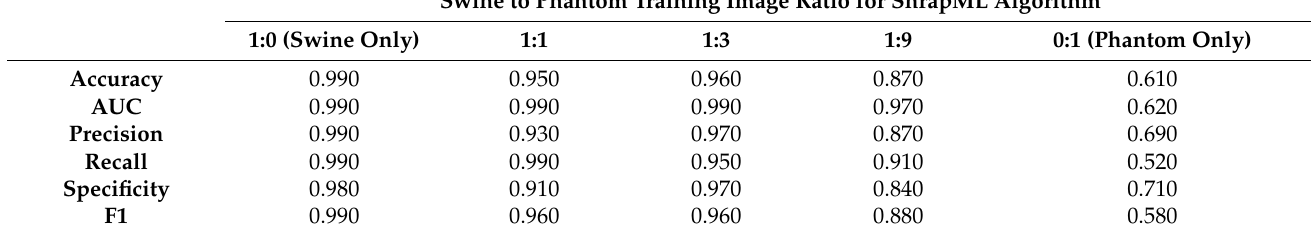
prediction accuracy for swine test